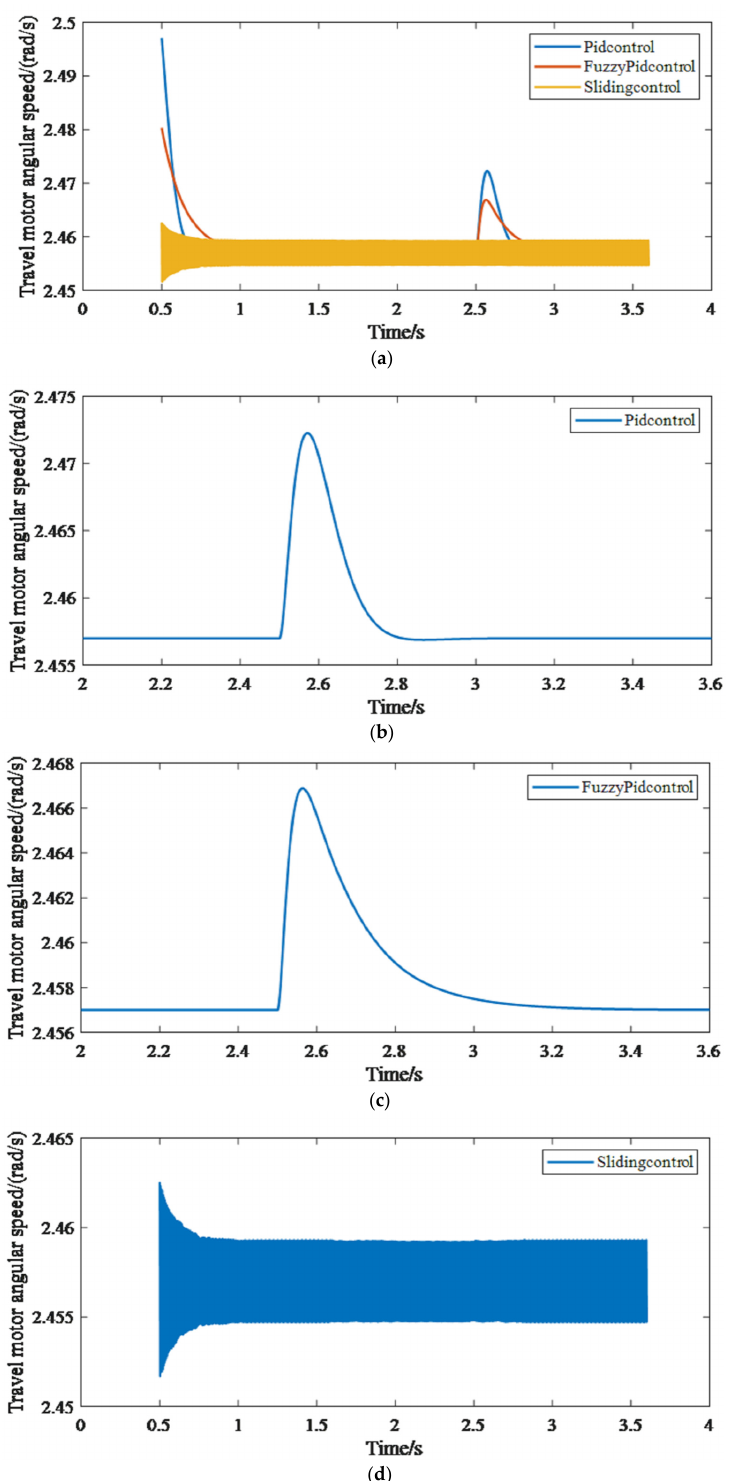
Figure 16. ( a ) Simulation results of sudden load shedding under smooth conditions of the travel drive system with three control strategies. ( b ) Simulation result of sudden load shedding under smooth conditions of the travel drive system with PID control strategy. ( c ) Simulation result of sud- den load shedding under smooth conditions of the travel drive system with adaptive fuzzy PID control strategy. ( d ) Simulation result of sudden load shedding under smooth conditions of the travel drive system with sliding mode control strategy. In summary, when the current value of the angular speed of the travel drive motor deviated from the set value by more than 2%, the travel drive system adjusted the travel speed through different control strategies to keep it within ±2% of the set value, thus re- alizing the automatic control function of the travel speed of the harvester. The dynamic response performance and stability of the sliding mode control strategy were significantly better than those of the PID and adaptive fuzzy PID control strategies. The sliding mode control strategy was more resistant to perturbations but oscillated weakly in the range of multiple steady states. The parameters of the sliding mode control strategy were: gain coefficient A = 1/70; gain coefficient c = 100; gain coefficient ε = 100; and gain coefficient k = 100. 3.2. Results of Field Trials To verify the accuracy of the simulation test results, the electric leafy vegetable har- vester based on PID, adaptive fuzzy PID, and sliding mode travel speed control modes were respectively applied to the vegetable sweet potato base of the Nanjing Institute of Agricultural Mechanization, Ministry of Agriculture and Rural Affairs. The proportional- ity factor KP of the travel speed PID control algorithm was set to 13.16 and the integration